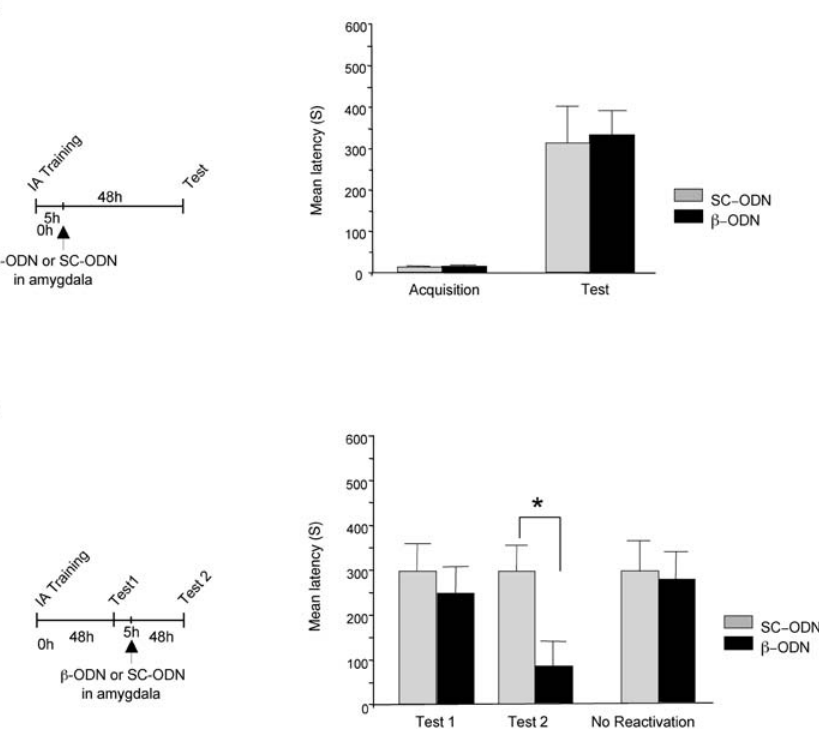
Figure 3. C/EBP b Is Required in the Amygdala for the Reconsolidation, but Not Consolidation, of IA Memory Latency to enter the shock chamber was taken as a measure of memory acquisition and retention. (A) Bilateral amygdala injections of b -ODN ( n ¼ 8) 5 h after training had no effect compared to SC-ODN injection ( n ¼ 8) on IA retention tested 48 h after training. (B) Bilateral amygdala injections of b -ODN 5 h after reactivation (Test 1, n ¼ 10) resulted in amnesia at Test 2, compared to SC-ODN injections ( n ¼ 8, * ¼ p , 0.05). DOI: